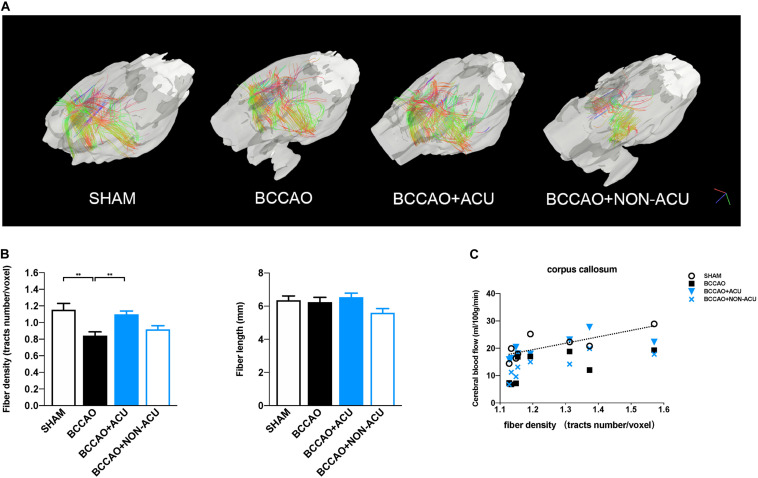
Visualization and Quantification of White Matter Tracts Indices in Rats. (A) Visualization of corpus collosum–associated white matter regions by reconstructing DTI images. (B) quantification of whiter matter fiber density (fiber number/voxel) and fiber length in SHAM, BCCAO, BCCAO + ACU, and BCCAO + NON-ACU groups. Data are presented as mean ± SEM (n = 8 per group). (C) The two-tail Pearson’s correlation coefficients between CBF and fiber density in the corpus callosum. ∗∗p < 0.01. SHAM, sham-operated group; BCCAO, BCCAO-operated group; BCCAO + ACU, BCCAO-operated + acupuncture at GV20 and ST36 group; BCCAO + NON-ACU, BCCAO-operated + acupuncture at non-acupoints group.